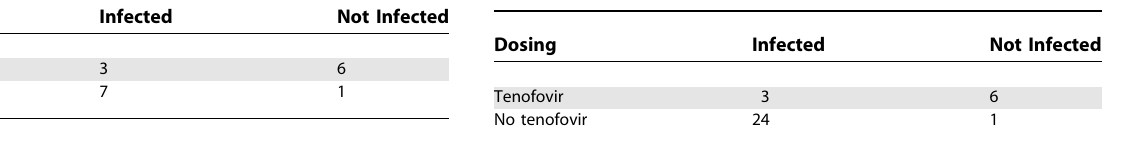
Table 4. Contingency Table for Dosing and Outcome of Virus Challenge: Analysis for ‘‘ Complete ’’ Protection, Including His- torical Controls Challenged with the Same Virus Stock Intra- rectally, Associated with Tenofovir Gel Administered Intrarectally Prior to Virus Challenge; p ,